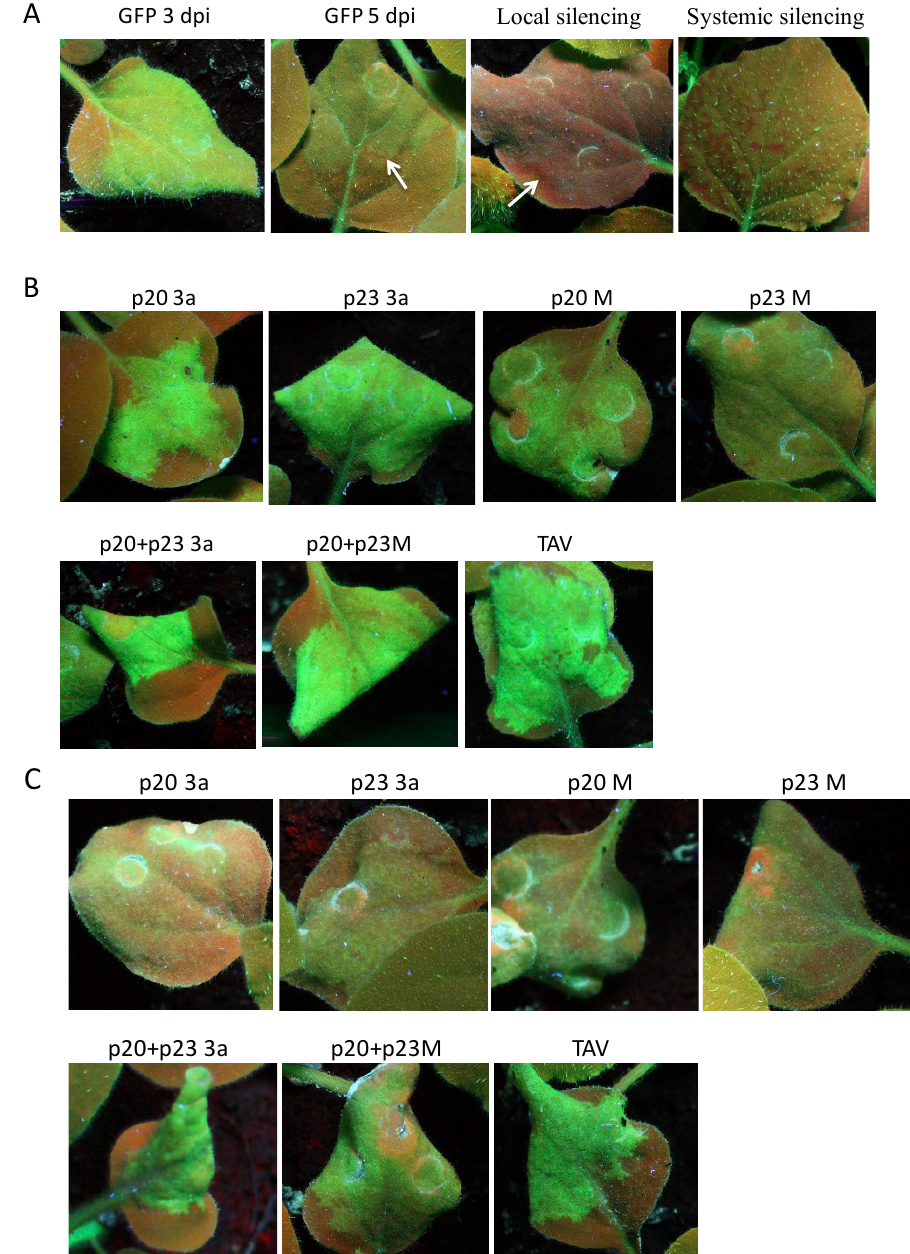
Figure 1. Visual observation of leaves from transgenic N. benthamiana 16C plants under UV light at 3, 5 and 9 days post- infiltration (dpi). A . Photographs of leaves infiltrated with Agrobacterium tumefaciens harbouring pK-GFP alone, showing transient GFP expression at 3 (GFP 3 dpi) and 5 (GFP 5 dpi) dpi, the short-range silencing signal (arrows), local silencing and the systemic silencing. B . GFP fluorescence images of leaves after co-infiltration of pK-GFP with TAV, with a single CTV VSR (p20 3a; p23 3a; p20 M; p23 M) and double co-infiltration of each p20 and p23 constructs from group 3a (p20+p23 3a) and group M (p20+p23 M), at 5 dpi. C . GFP fluorescence images of leaves after co-infiltration of pK-GFP with